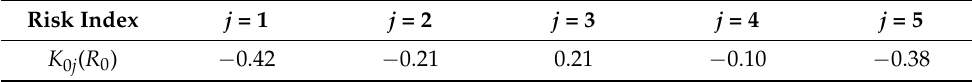
Table 7. Comprehensive relevance degree under each risk